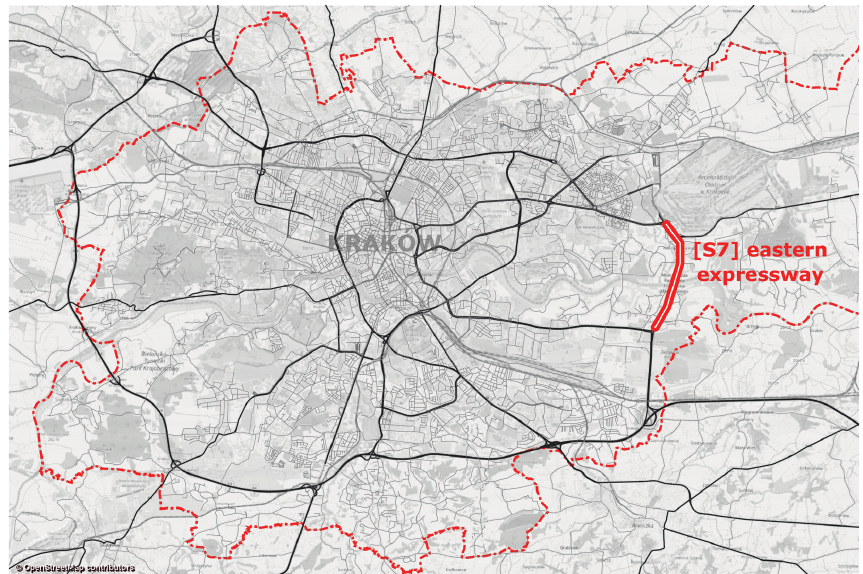
Figure 1: Analysed road segment of the expressway S7 (marked red) forming eastern bypass of the Krakow city, with a new bridge crossing over Vistula river (©